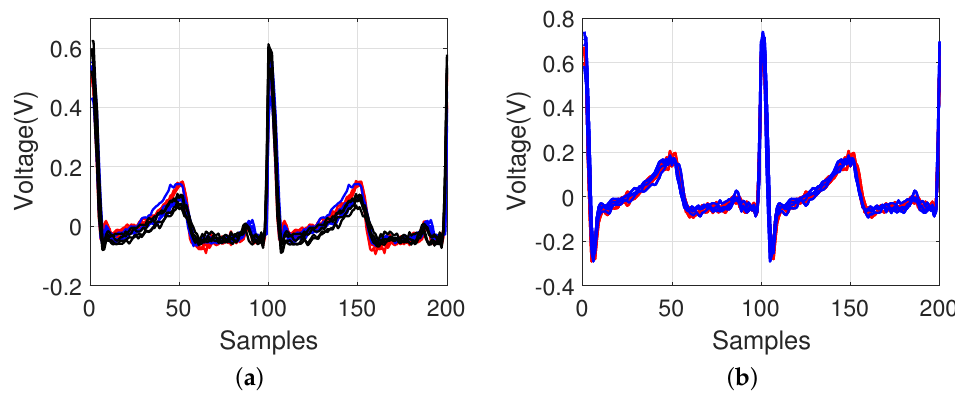
Figure 9. Examples of ECG pattern shown by an overlapping to compare the changes after some period or after smoking; ( a ) after some period (red-colored line: reference, blue-colored line: after 7 days, black-colored line: after 20 days) and ( b ) before and after smoking (red-colored line: after, blue-colored line: before).